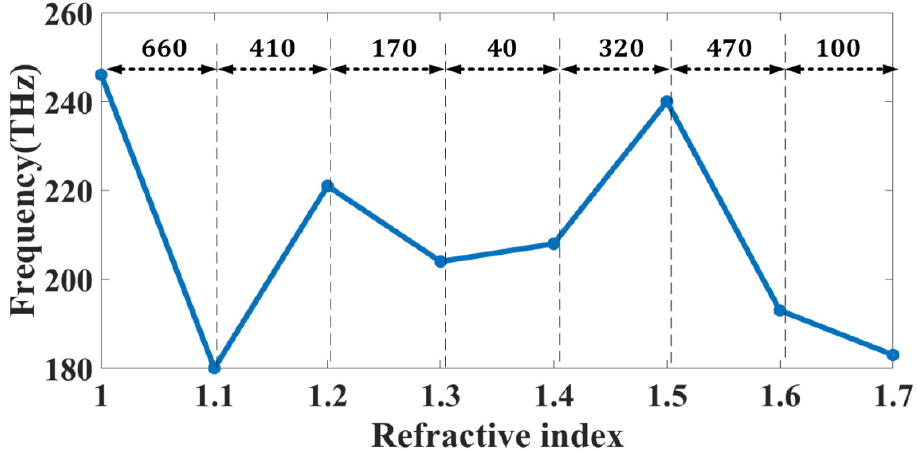
Figure 8. Variation in the peak resonance frequency for the different values of the refractive index of sample material.